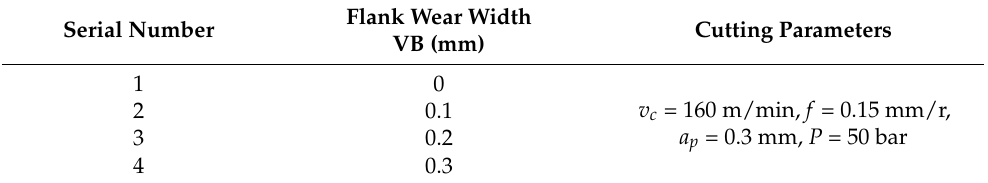
Table 5. Experiment parameter design.